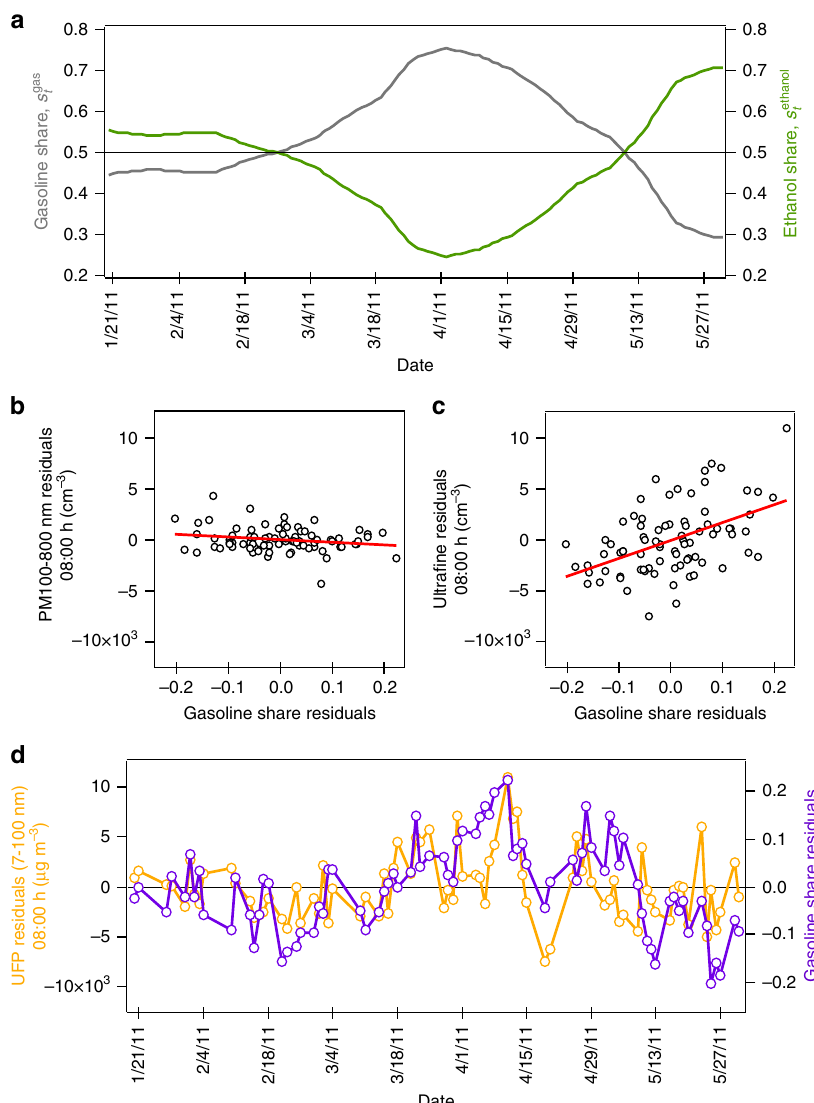
Fig. 2 Submicron particles and the gasoline share. a Fuel share variation among fl ex-fuel vehicles from January to May 2011. b Co-variation of PM 100 – 800 nm and c ultra fi ne number concentration residuals with gasoline share residuals for the weekday morning hour of 08:00 in the same period. The red line marks the best linear predictor. d Morning-hour variation of ultra fi ne number concentration and gasoline share residuals over the period.